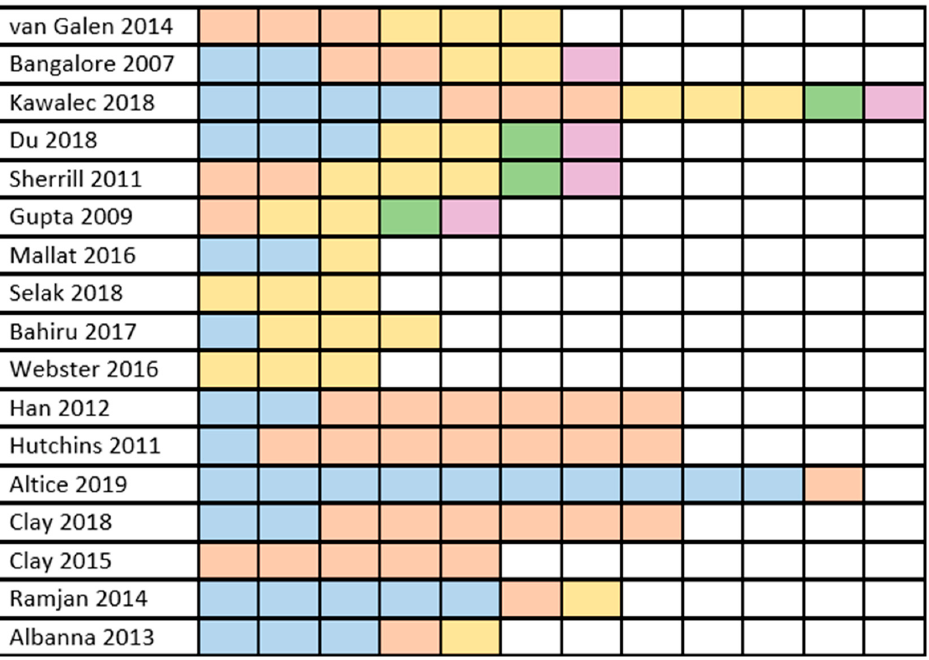
FDCT, fixed-dose combination therapy; MPT, multipill therapy; CVD, cardiovascular disease; HIV, human immunodeficiency virus.